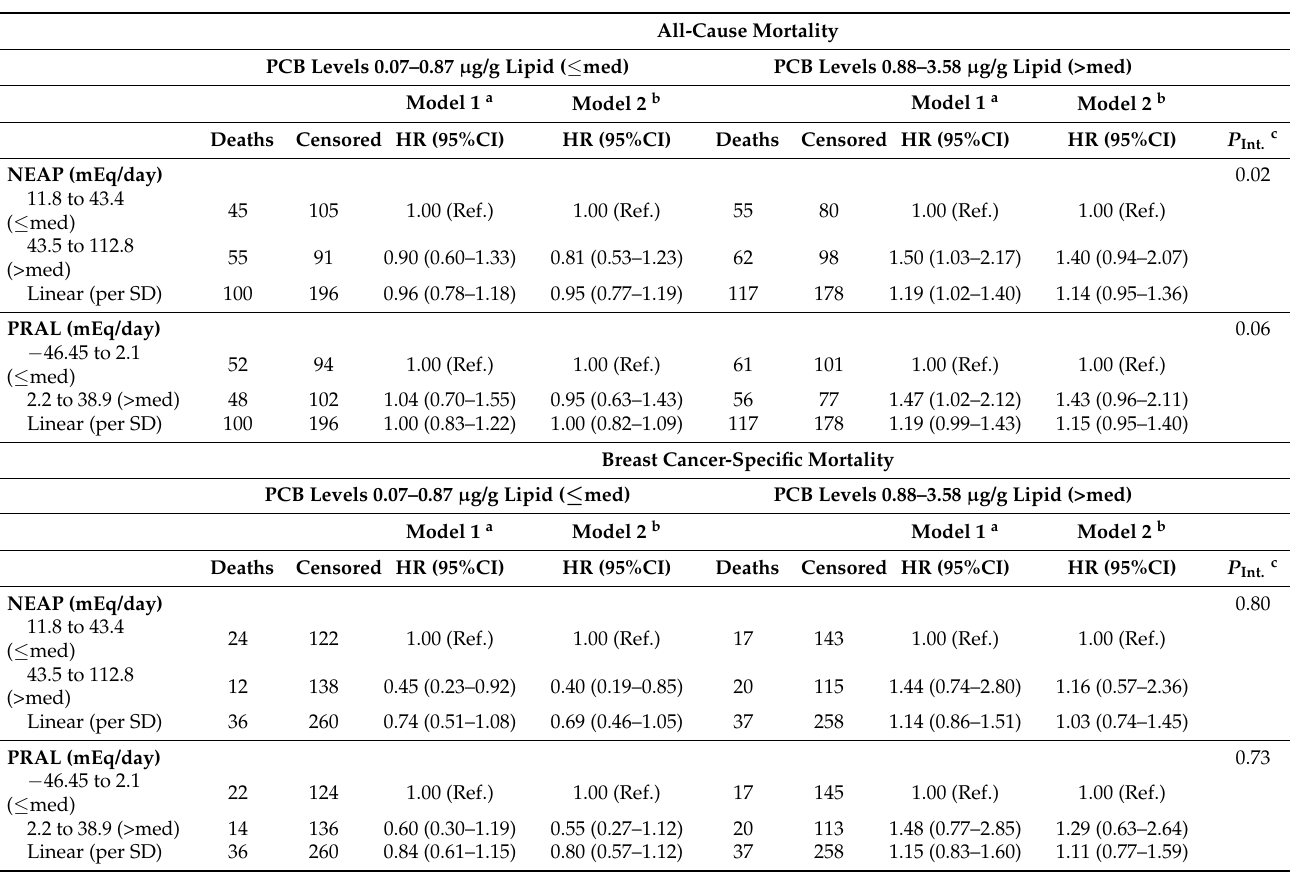
Table 4. Hazard ratios (HRs) and 95% confidence intervals (CIs) for the associations between dietary acid load scores and all-cause and breast cancer-specific mortality by serum total lipid-adjusted PCB levels ( n =